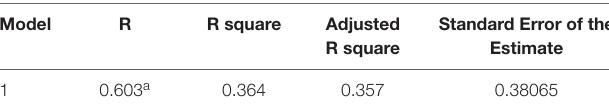
TABLE 3A | Model summary: Effect of predictor variables on the criterion variable.